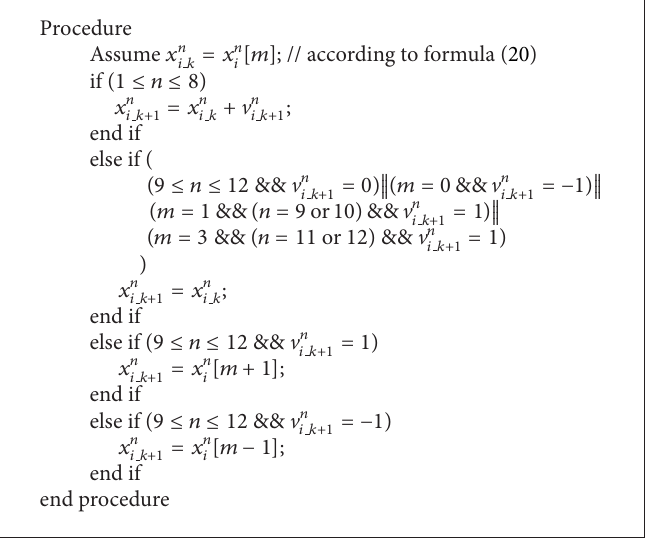
Algorithm 1: Pseudocode for the position update procedure.